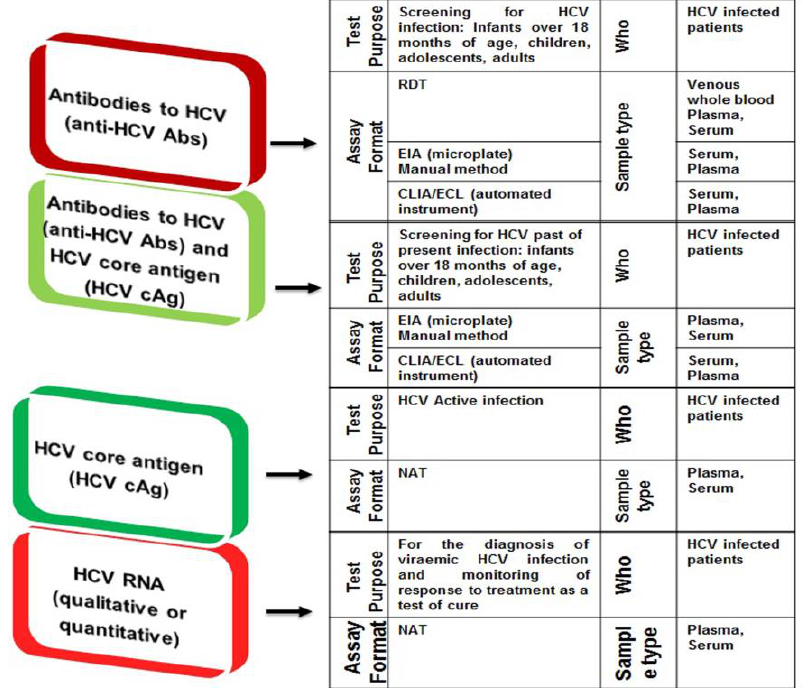
Figure 4. HCV diagnostic platforms with their purpose of use, assay format, sample type, and for which type of test to be used. WHO and international HCV diagnostic and treatment guidelines releasing organizations recommend three types of HCV screening and infection diagnosis testing strategies for general HCV-affected populations and high-risk HCV populations [48]. RDT = rapid diagnostic test, EIA = enzyme immunosorbent assay, EIA = electrochemiluminescence, CLIA = chemiluminescent immunoassay, NAT = nucleic acid testing.